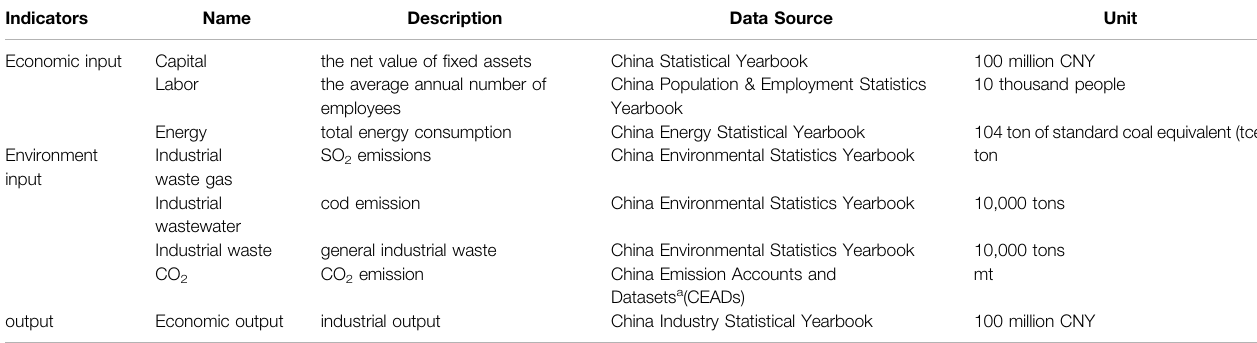
TABLE 1 | Variables Description in super-ef fi ciency DEA